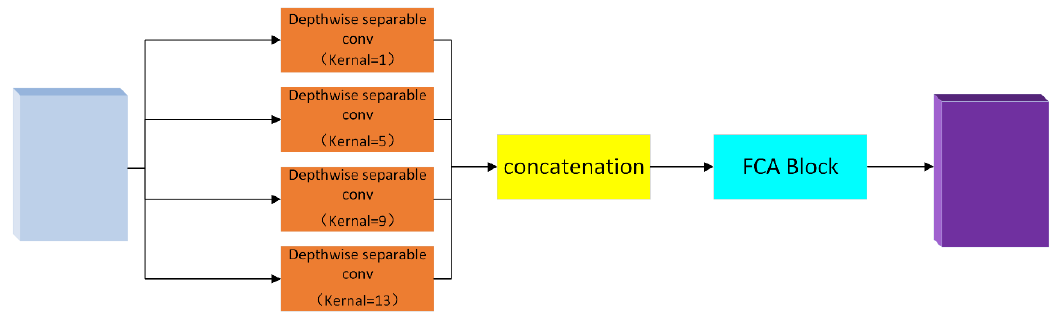
Figure 3. Diagram of the depthwise FCA block structure.